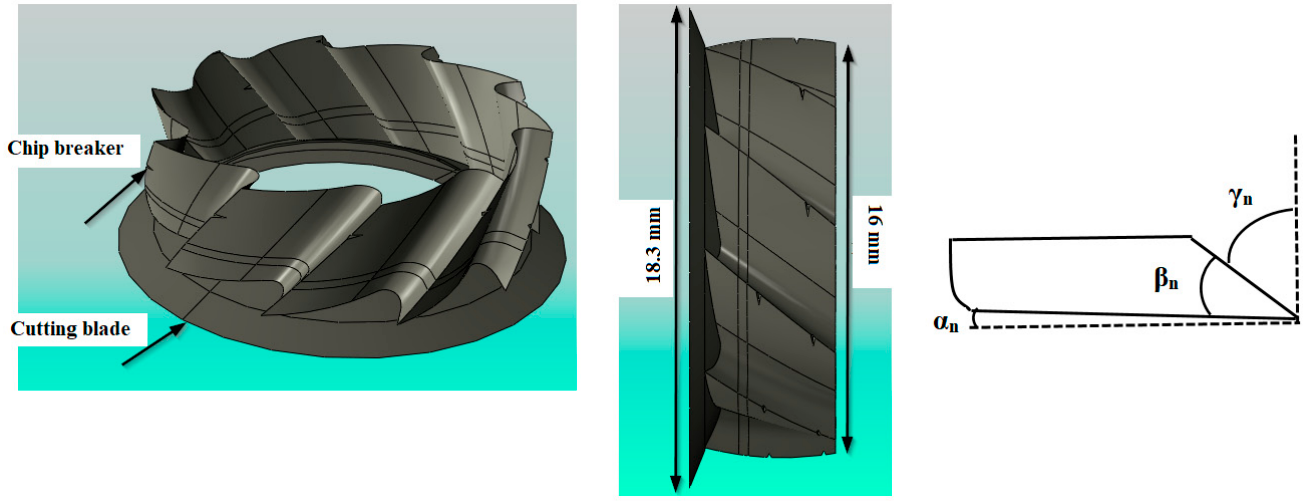
Figure 2. Geometric dimensions of the CZ10 cutting tool used during the simulation.